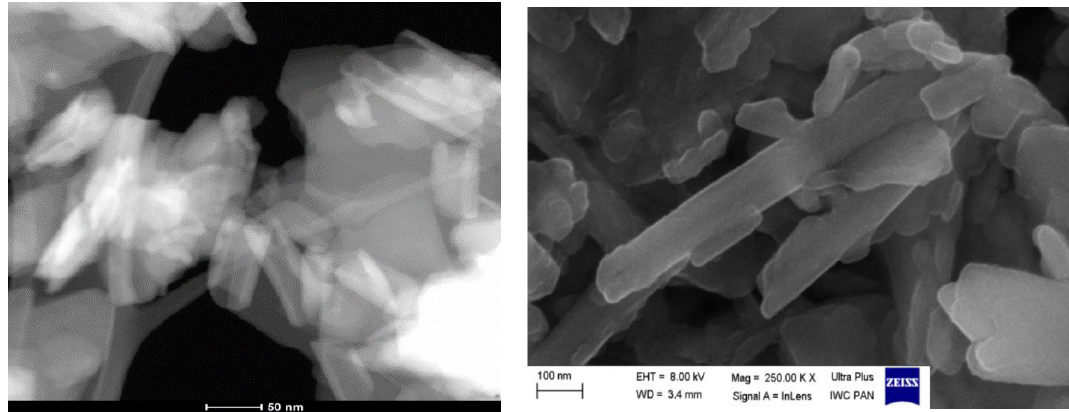
Figure 5. ( left ) TEM and ( right ) SEM images of the HAL sample.